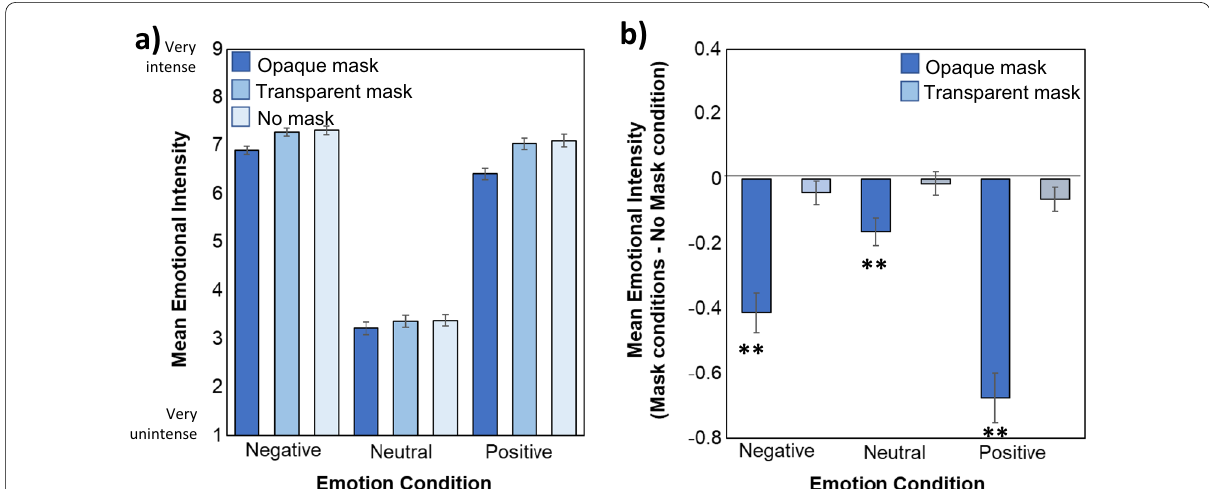
Fig. 3 a The assumed emotional intensity of protagonists during each Emotion and Mask condition on a scale from 1/very un-intense to 9/very intense. b Comparison of intensity ratings for protagonists wearing opaque and transparent masks relative to those with no masks for each Emotion condition (calculated by subtracting the no mask baseline from the mask conditions). Bigger bars indicate a bigger difference from the No mask condition, with * and ** indicating a significant difference from the No mask condition at p < .05 and p < .01, respectively. Error bars represent standard error of the